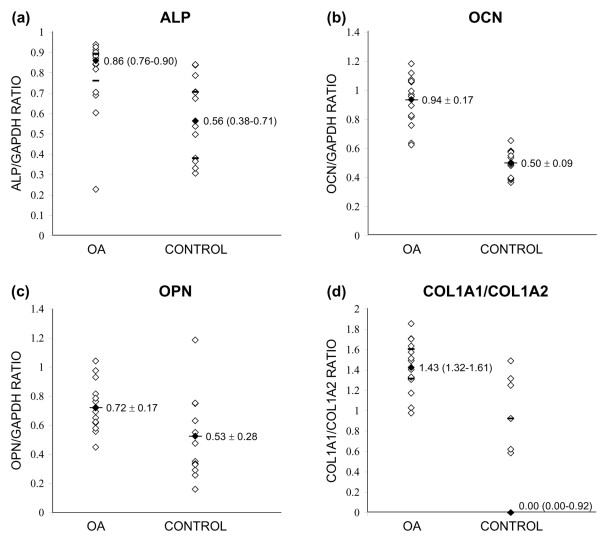
Relative polymerase chain reaction product/GAPDH ratios for alkaline phosphatase (ALP), osteocalcin (OCN), and osteopontin (OPN) and the relative ratio of COL1A1/COL1A2. mRNA expression in intertrochanteric trabecular bone was compared between the osteoarthritis (OA) (n = 15) and control (n = 13) groups. Patients with OA had significantly elevated (a) ALP/GAPDH (p < 0.002), (b) OCN/GAPDH (p < 0.0001), (c) OPN/GAPDH (p < 0.05), and (d) COL1A1/COL1A2 (p < 0.0001) mRNA ratios versus controls. Data are expressed as parametric mean ± standard deviation (open diamond) and non-parametric median (closed diamond) and quartile (dash) range. COL1A, collagen type I alpha chain; GAPDH, glyceraldehyde-3-phosphate dehydrogenase.